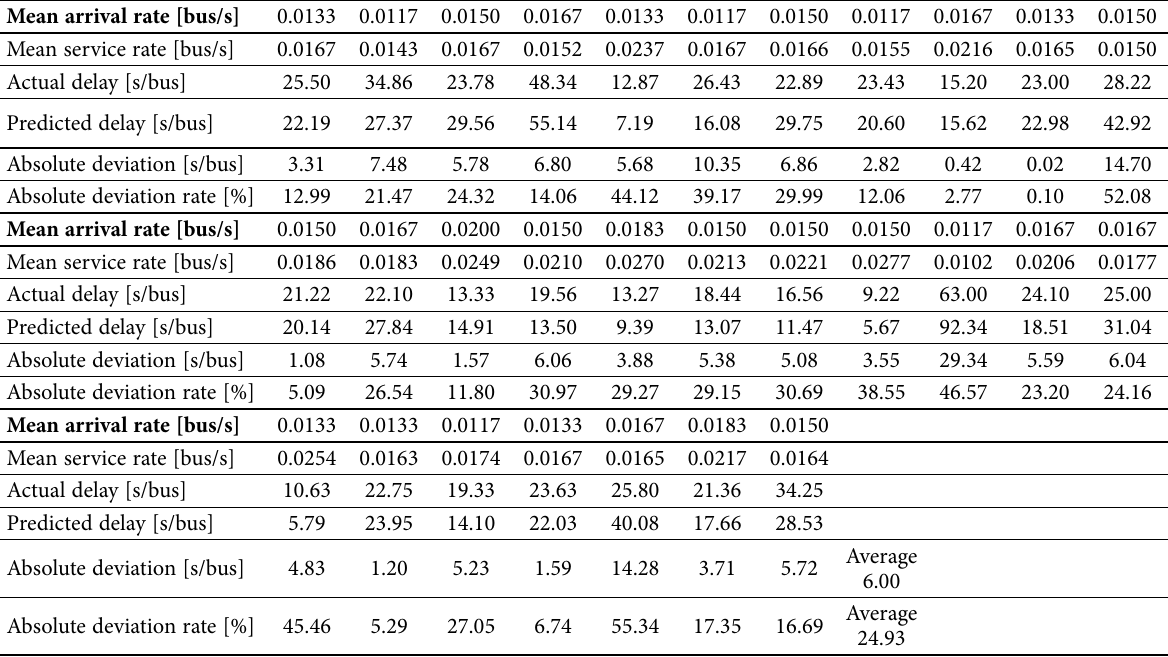
Table 1. Absolute deviation is equal to absolute value of actual delay minus predicted delay. Absolute deviation rate is equal to absolute deviation divided by actual de- Table 1. Mean arrival rate, mean service rate, actual delay, predicted delay, absolute deviation and absolute deviation rate for model validation ( berth number = 2, red time = 42 s, cycle length = 65 s) Mean arrival rate [bus/s]